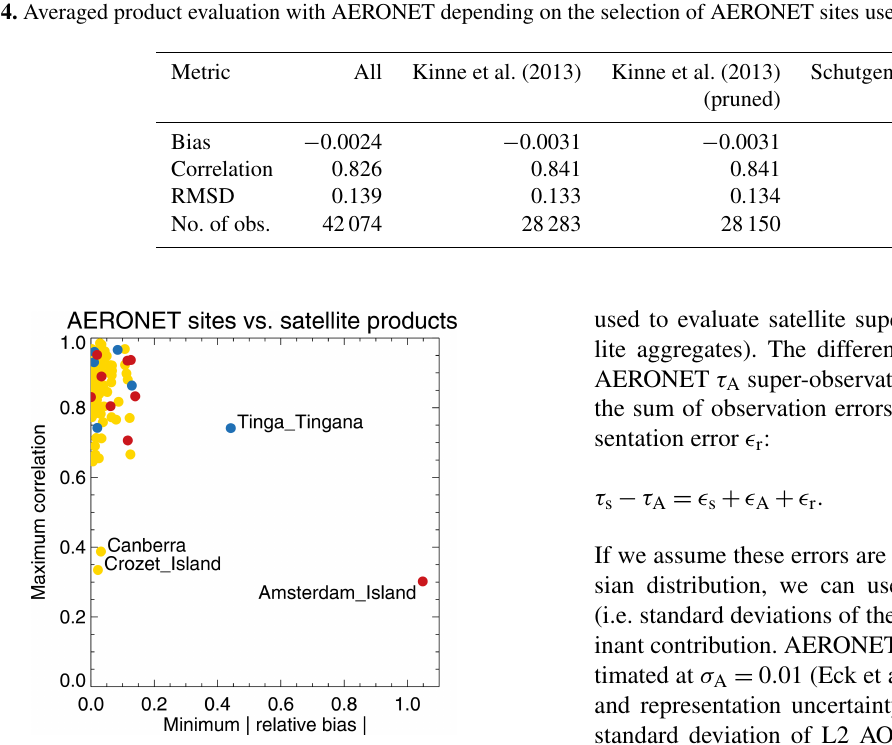
Figure 2. Minimum relative bias (sign-less) and maximum corre- lation per AERONET site, over all products. Red symbols indi- cate AERONET site bias is always positive; blue symbols indicate AERONET site bias is always negative. Yellow symbols indicate that site bias is positive versus some products and negative ver- sus others. Products were individually collocated with AERONET (Kinne et al., 2013, selection) within